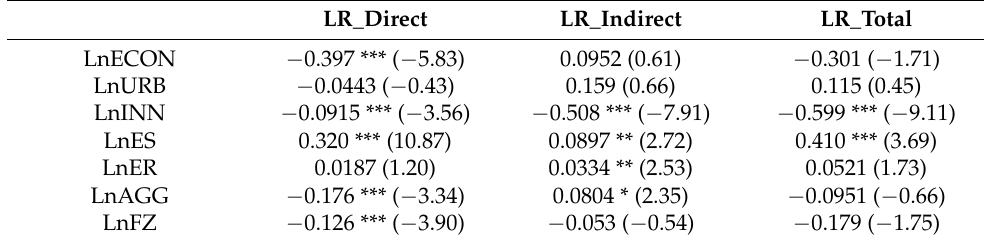
Table 6. Results of direct effects, indirect effects and total effects for